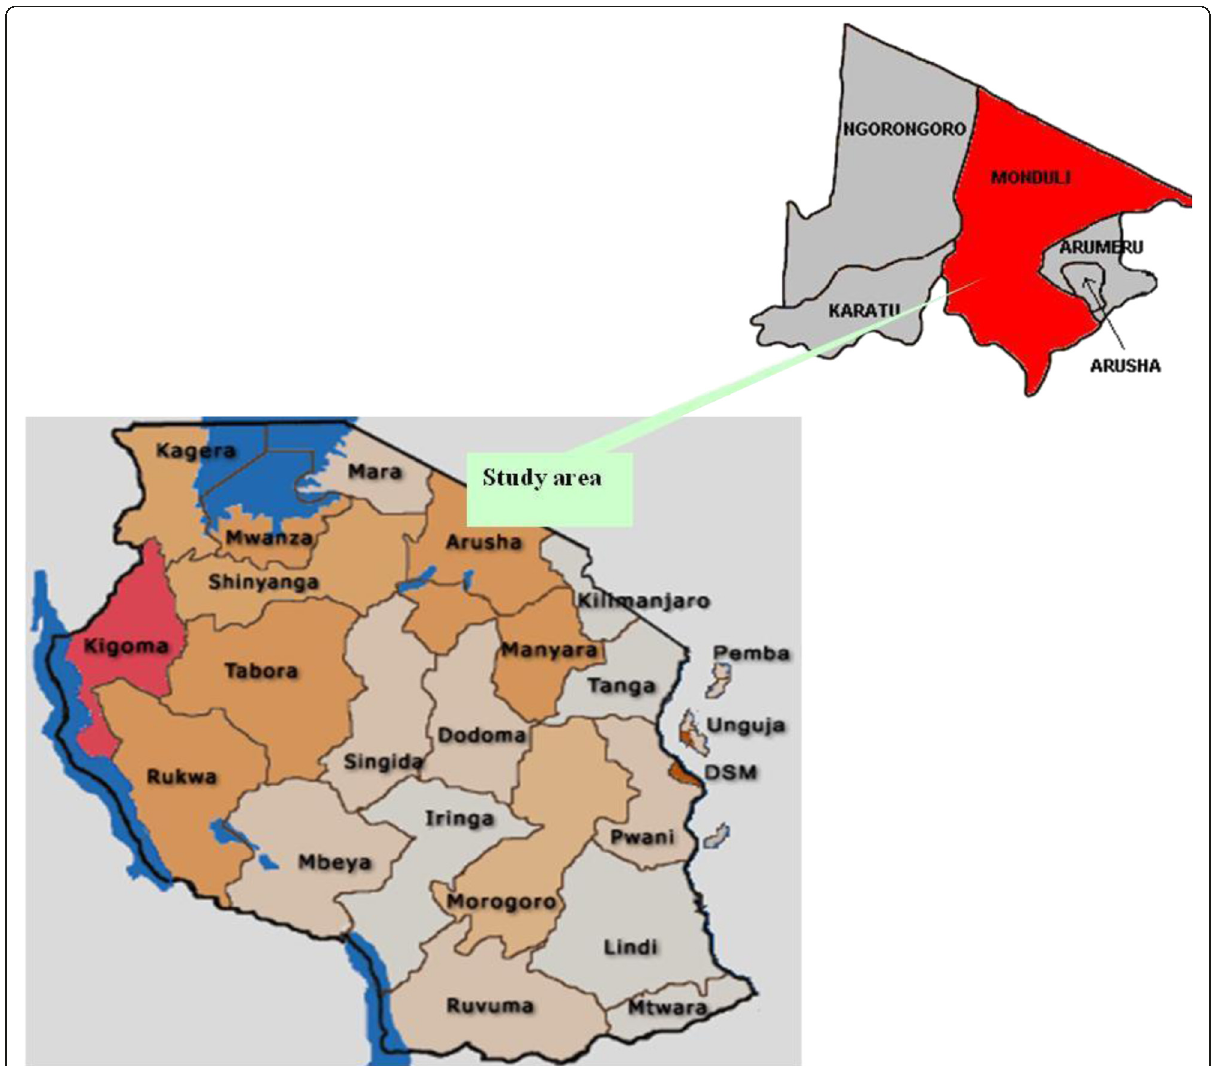
Fig. 1 Map of the United Republic of Tanzania showing adminstrative regions, as well as Monduli district ( in red ) and the neighboring Arumeru district, in Arusha, where the two communities investigated in this study are located (image adapted from: